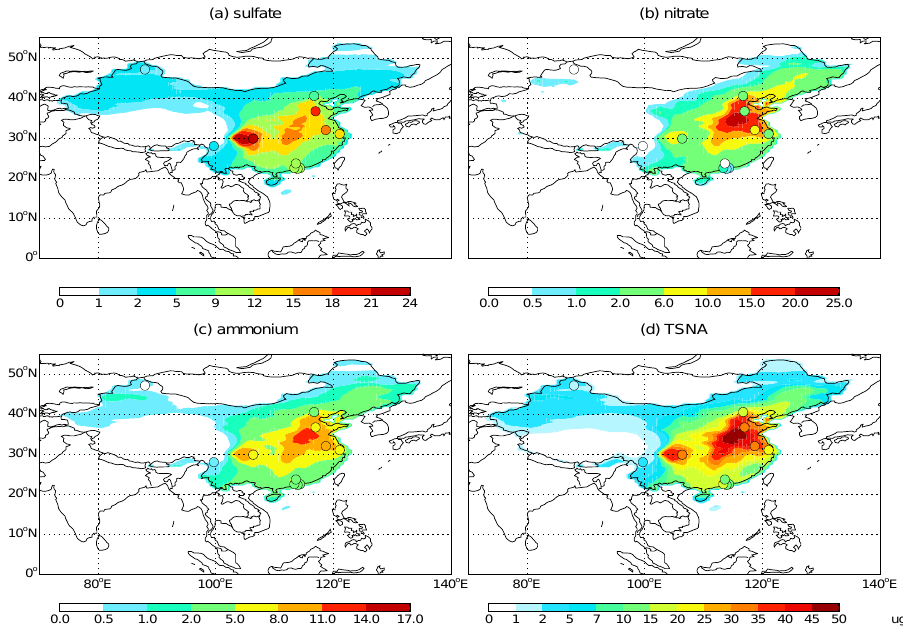
Fig. 4. Overlay of simulated (color map) and observed (colored circles) annual mean surface concentrations of total SNA (TSNA), sulfate, nitrate and ammonium over China. Observations are derived from the MY and BB sites with weekly measurements and from the 9 sites in published literature (i.e., the blue triangle sites shown in Fig.